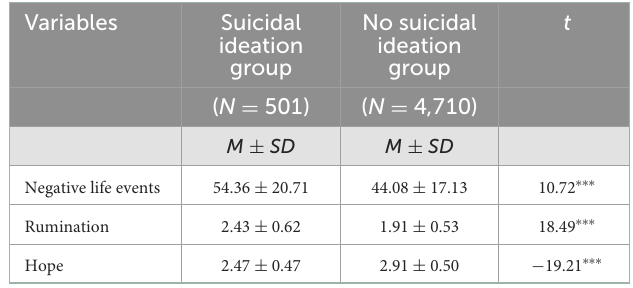
TABLE 2 T -test of concerned variables between the groups with and without suicidal ideation.